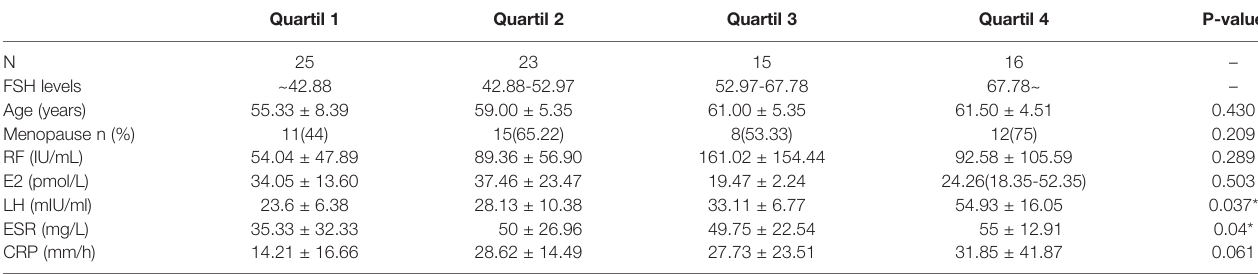
TABLE 3 | Clinical characteristics and sex hormone levels in RA patients with different FSH levels.